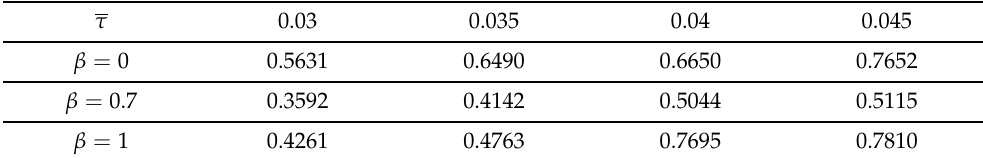
Table 8. Minimum γ for various of τ and β values in Case 3.